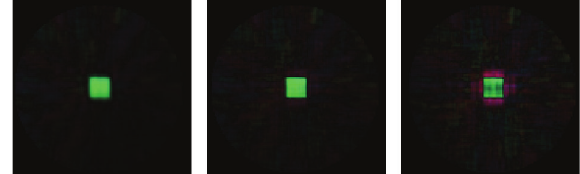
Figure 7: Reconstruction of a cubic phantom using 178 trajectories. (Left to right) Original 32-channel reconstruction, image showing some edge enhancement after one gradient step, and the gradient (not to scale).